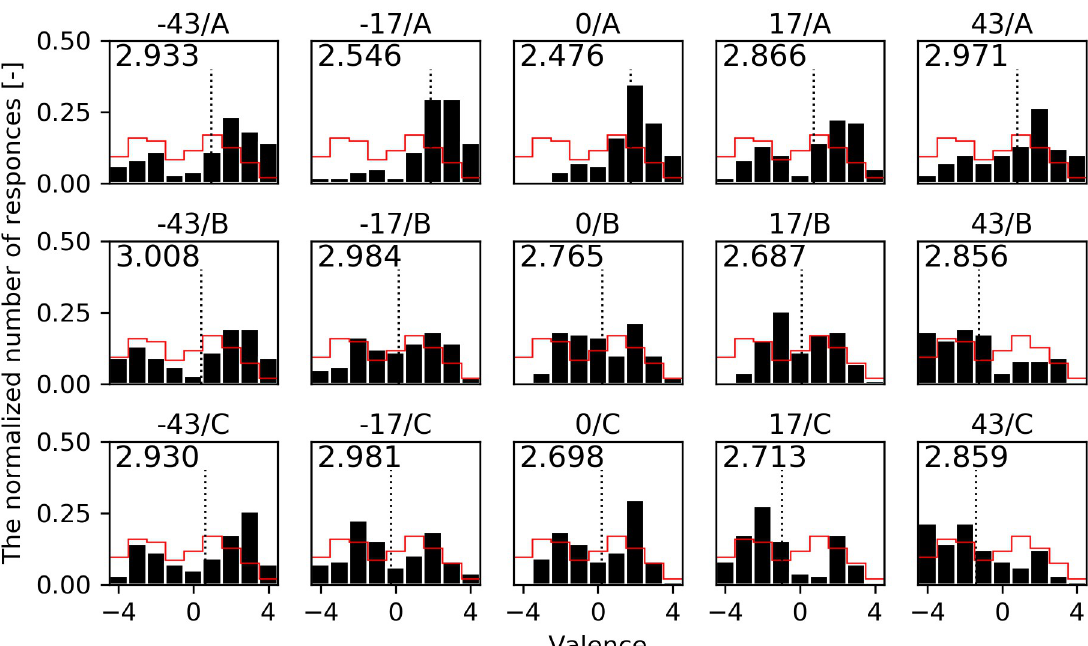
Fig 7. Distributions of the assessed facial valence in Experiment 2. The horizontal axis shows the assessed facial valence (-4 to 4) and the vertical axis shows the normalized number of responses. The dotted line shows the mean facial valence. The red line on the histogram shows the result of the intense facial expressions in Experiment 1 as a reference. The entropy is shown in the upper left of each